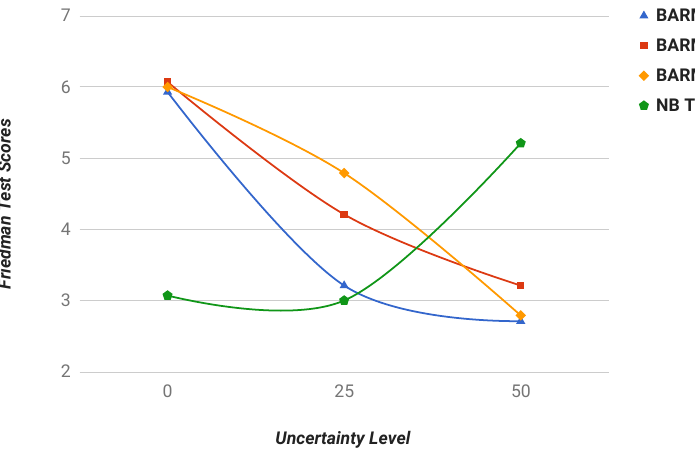
Figure 6. Friedman test scores for the best classifiers by uncertainty